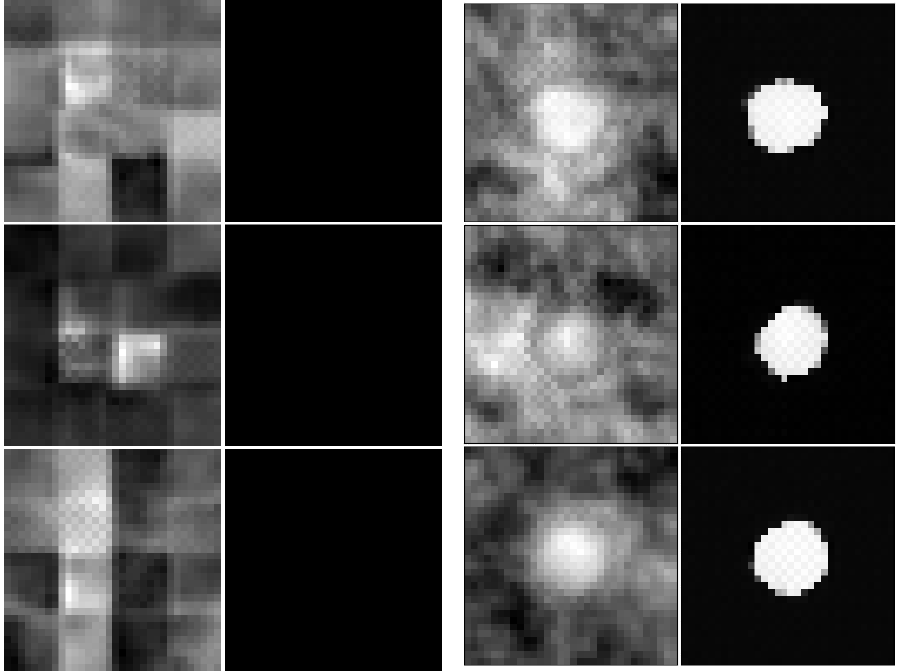
Figure 14. Three samples (pairs of lumen image and segmentation mask) generated by the proposed network ( right ) and by the baseline model ( left